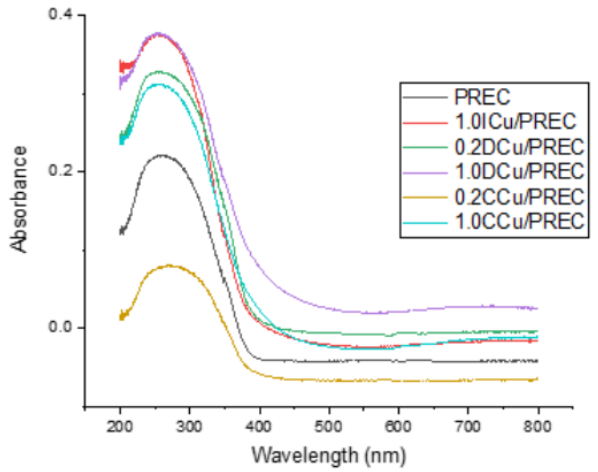
Figure 6. Di ff use reflectance (DR) UV-Vis analysis for Cu-loaded Figure 6. Diffuse reflectance (DR) UV-Vis analysis for Cu-loaded samples. Figure 6. Diffuse reflectance (DR) UV-Vis analysis for Cu-loaded samples.